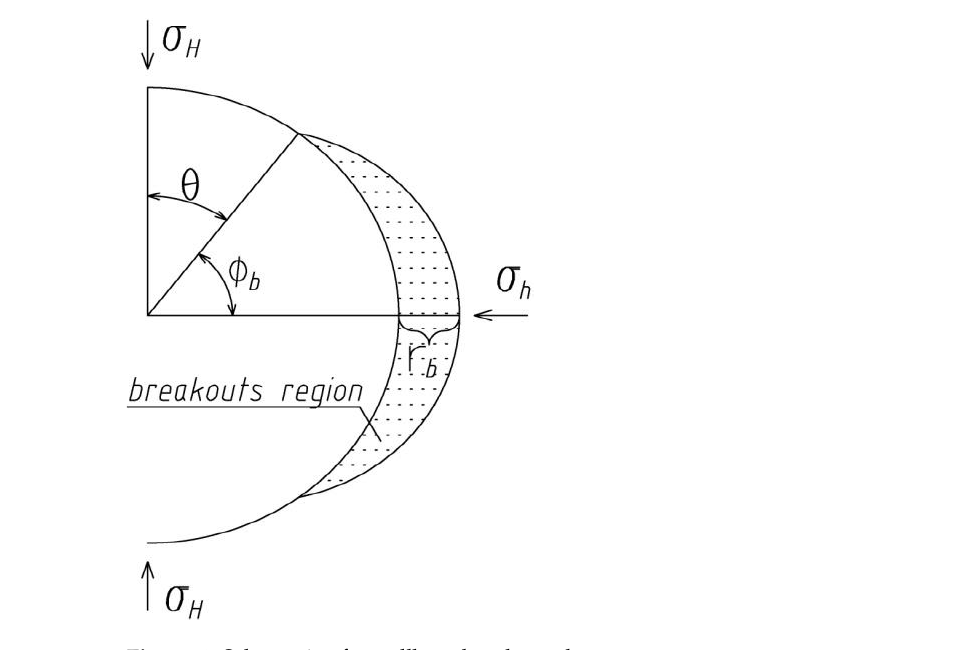
Figure 3. Mesh of finite element model.